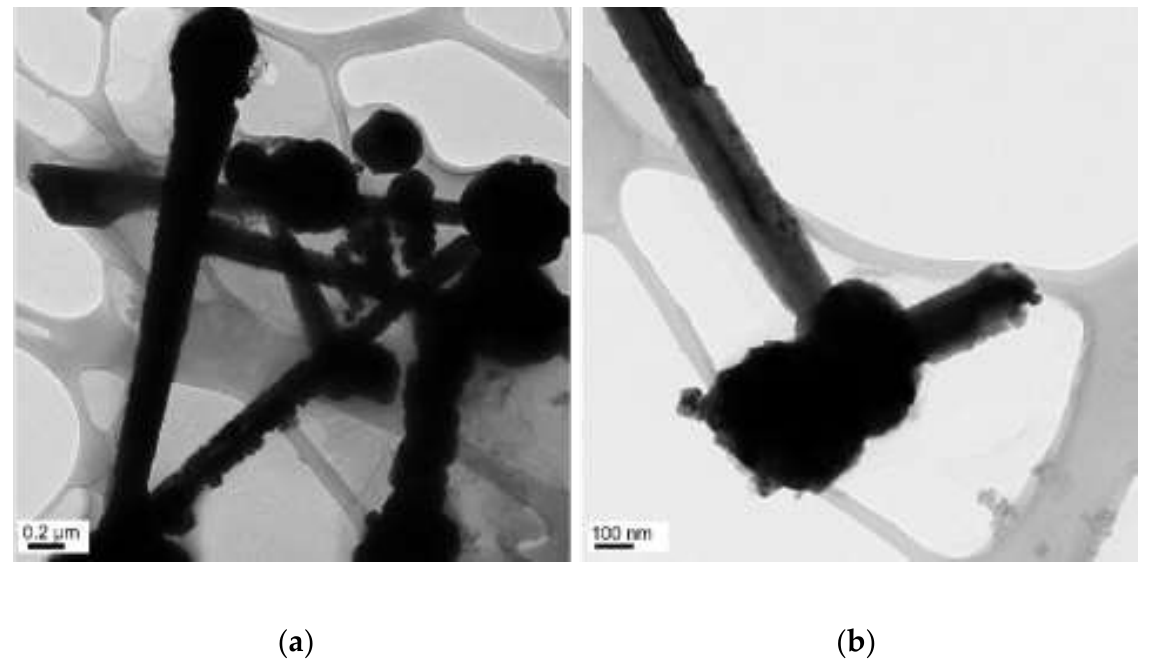
Figure 8. TEM images of copper nanowires with 15 µL of EDA: ( a ) scale bar 0.2 µm; ( b ) scale bar 100 nm.